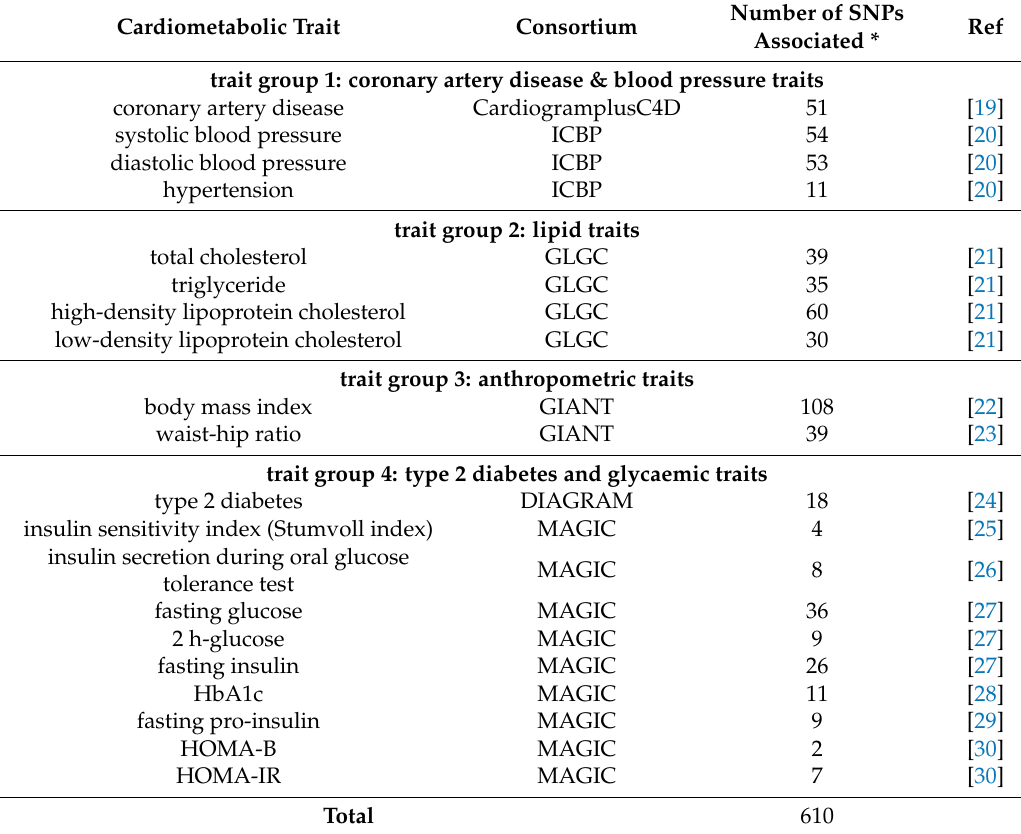
Table 1. GWAS related to cardiometabolic